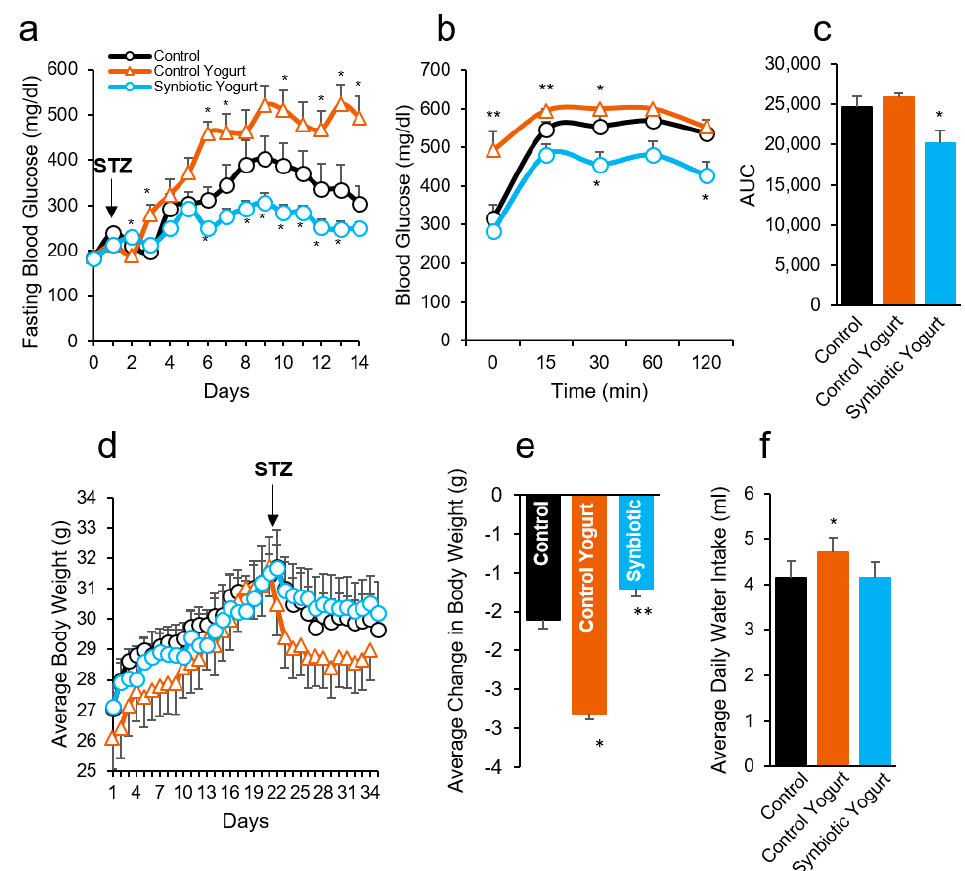
Figure 1. Synbiotic yogurt feeding protects against diabetes progression in mice. ( a ) Synbiotic yogurt feeding significantly reduced the rise in fasting blood glucose levels following STZ administration. ( b , c ) Meal tolerance test ( b ) and area under the curve ( c ) were also reduced in synbiotic yogurt-fed mice compared to their controls. ( d , e ) Daily body weight ( d ) and average change in body weight following STZ administration ( e ). ( f ) Average daily water intake. Values are mean ± standard error of the mean (error bars). Values with * p < 0.05; ** p < 0.001 are statistically significant. AUC, Area under curve; STZ, Streptozotocin.